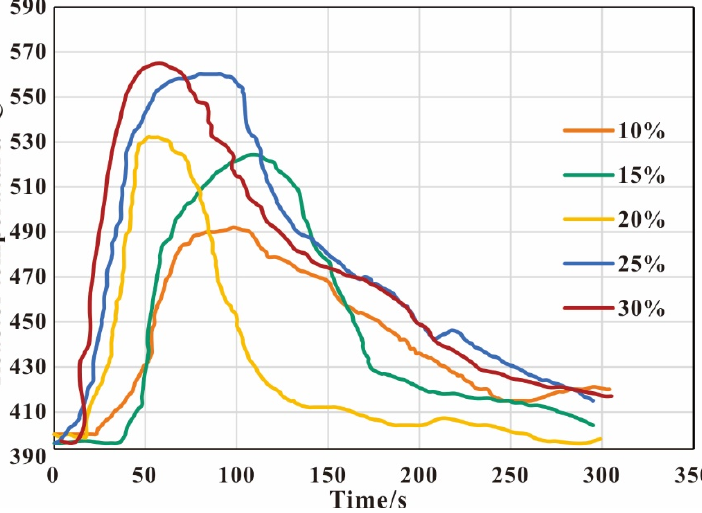
Figure 12. Temperature changes in the reactor during the supercritical water–crude oil reaction